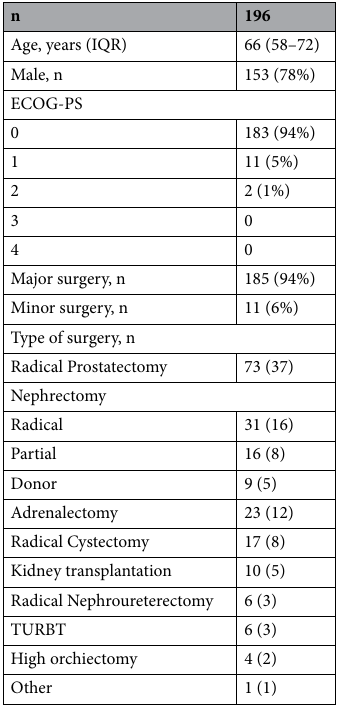
Table 1. Background of patients. IQR interquartile range, ECOG-PS Eastern cooperative oncology group performance status, TURBT transurethral resection of bladder tumor.